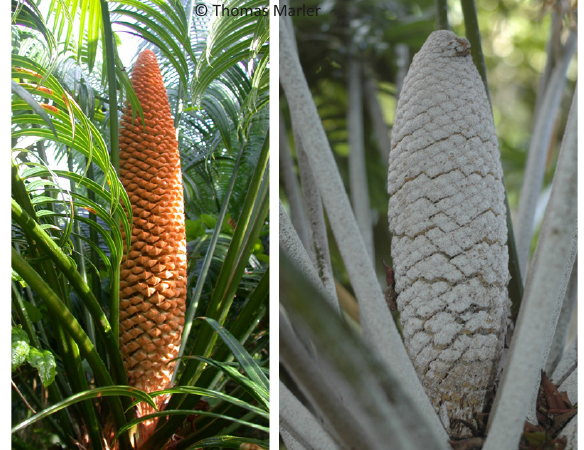
Image 2. Cycas micronesica male strobili are borne terminally on stems (left), and are susceptible to direct attack by Aulacaspis yasumatsui